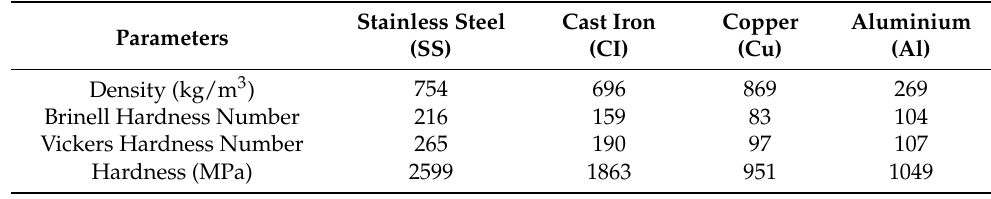
Table 1. Specifications of the tested immersion test sample.